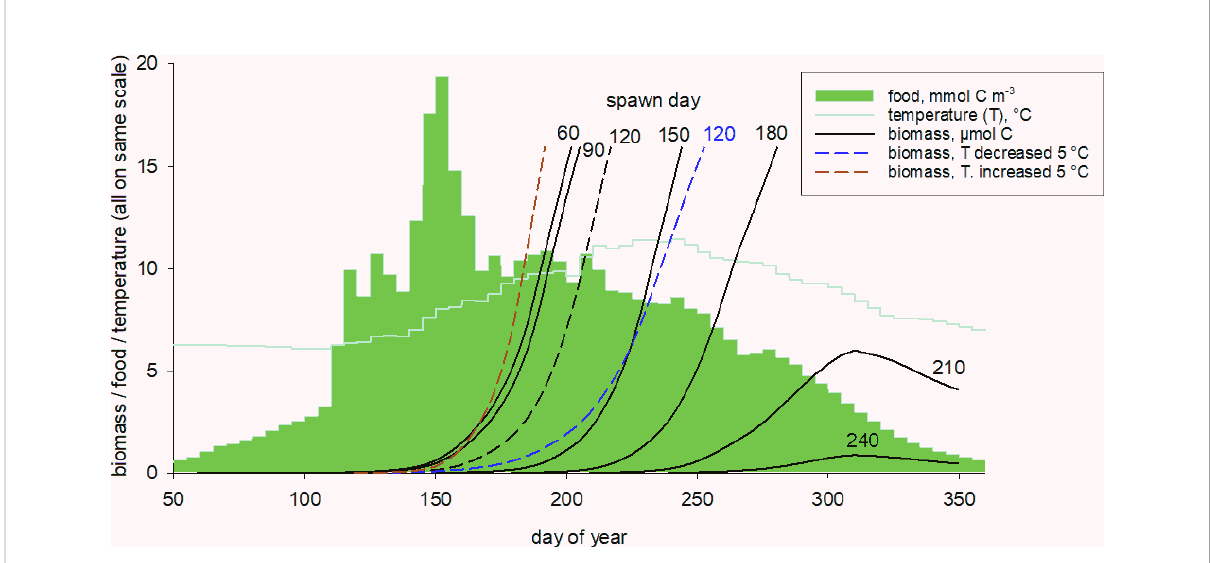
FIGURE 7 Predicted biomass (structure + lipid) development in spring to full-size CV (end of Phase 3) for animals spawned on days 60, 90, 120, … , 240. The default setting (day 120) is subjected to a sensitivity analysis where temperature is decreased/increased by 5°C (colour dashed lines). Seasonal food fi elds and temperature also shown (all plots are on the numerical same scale, although with different